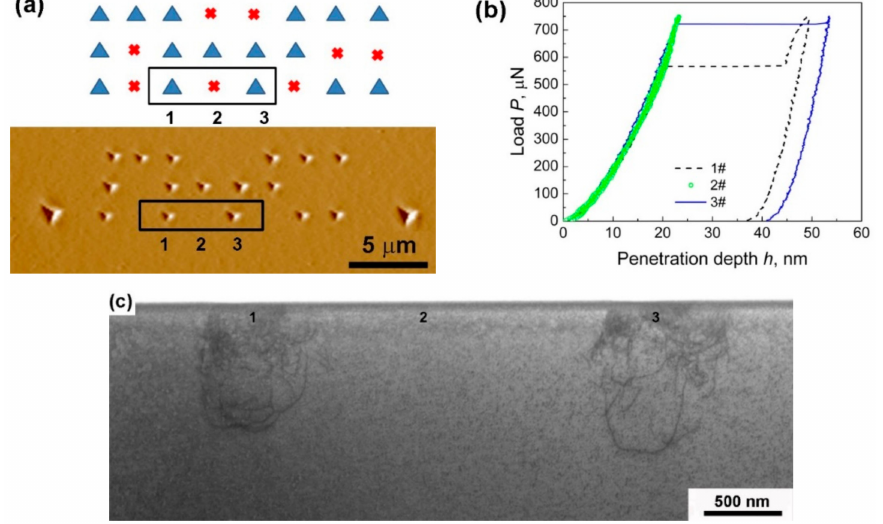
Figure 4. ( a ) SPM image of indentation marks on the sample surface, ( b ) the corresponding load– displacement curves, and ( c ) the cross-sectional TEM images of the dislocation structures just below the indentation marks